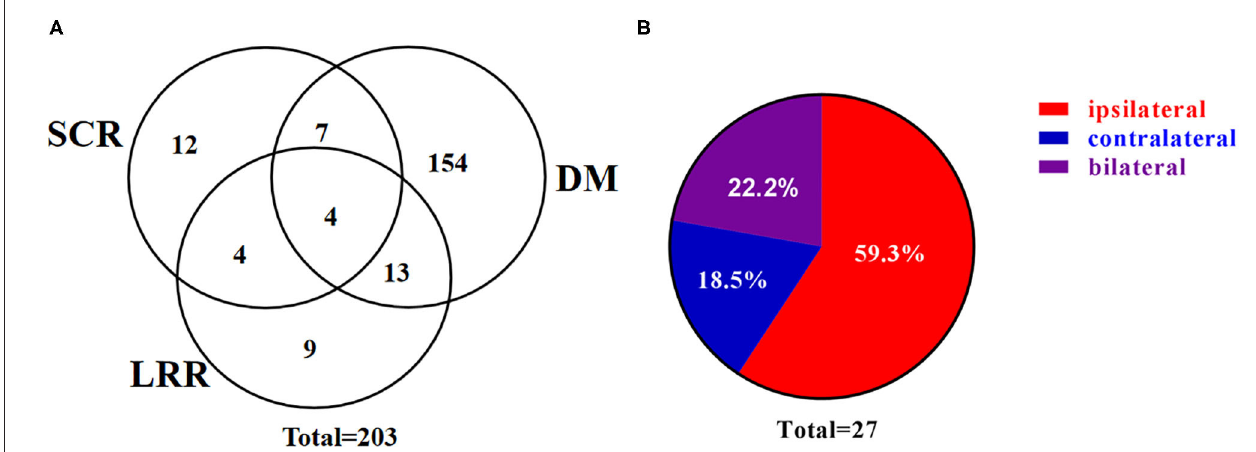
FIGURE 1 | Patterns of supraclavicular recurrence. (A) Venn diagram demonstrating the distribution of initial postoperative recurrence. (B) Pie chart demonstrating the distribution of SCR. SCR, supraclavicular recurrence; LRR, loco-regional recurrence; DM, distant metastasis.